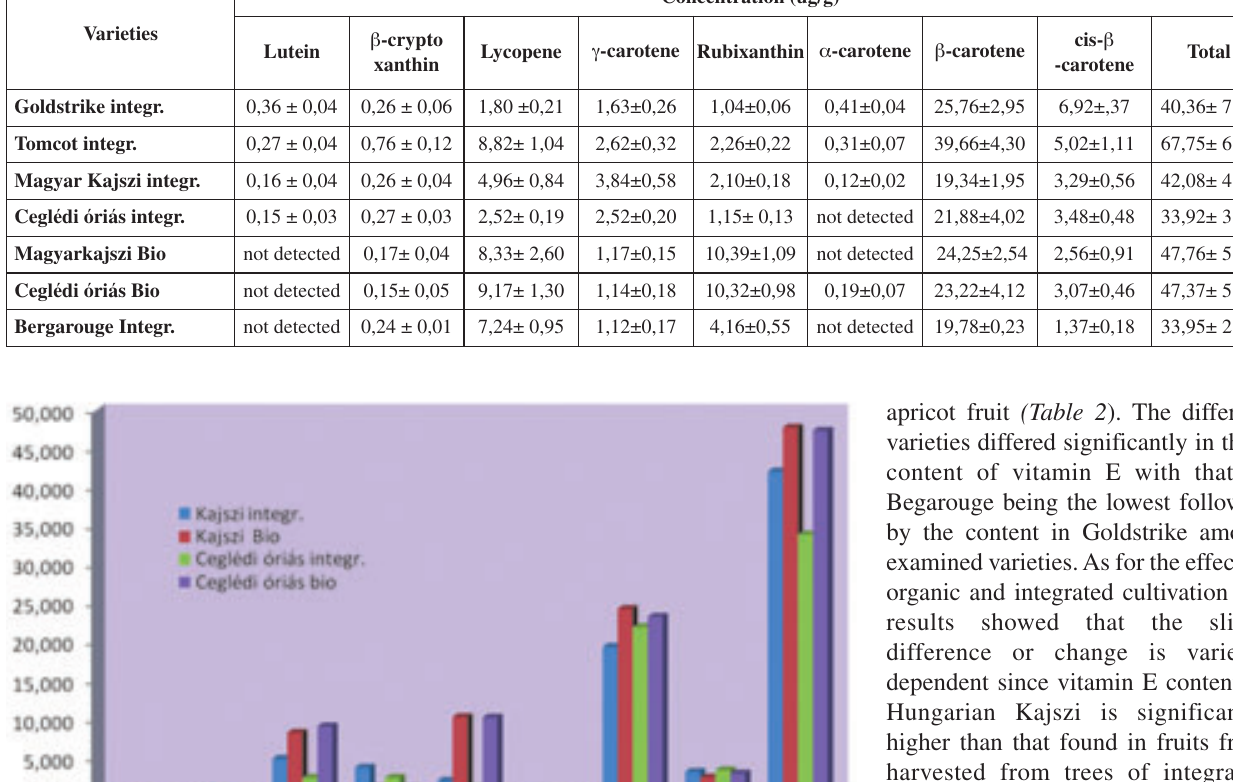
Goldstrike integr.